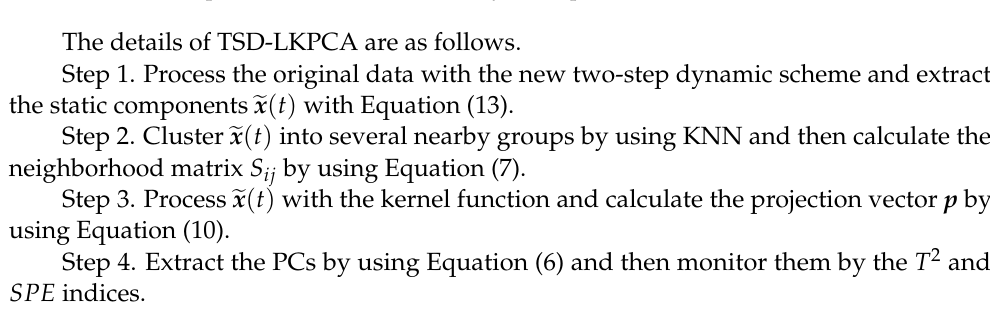
Figure 3. Static components extracted from the dynamic process data.